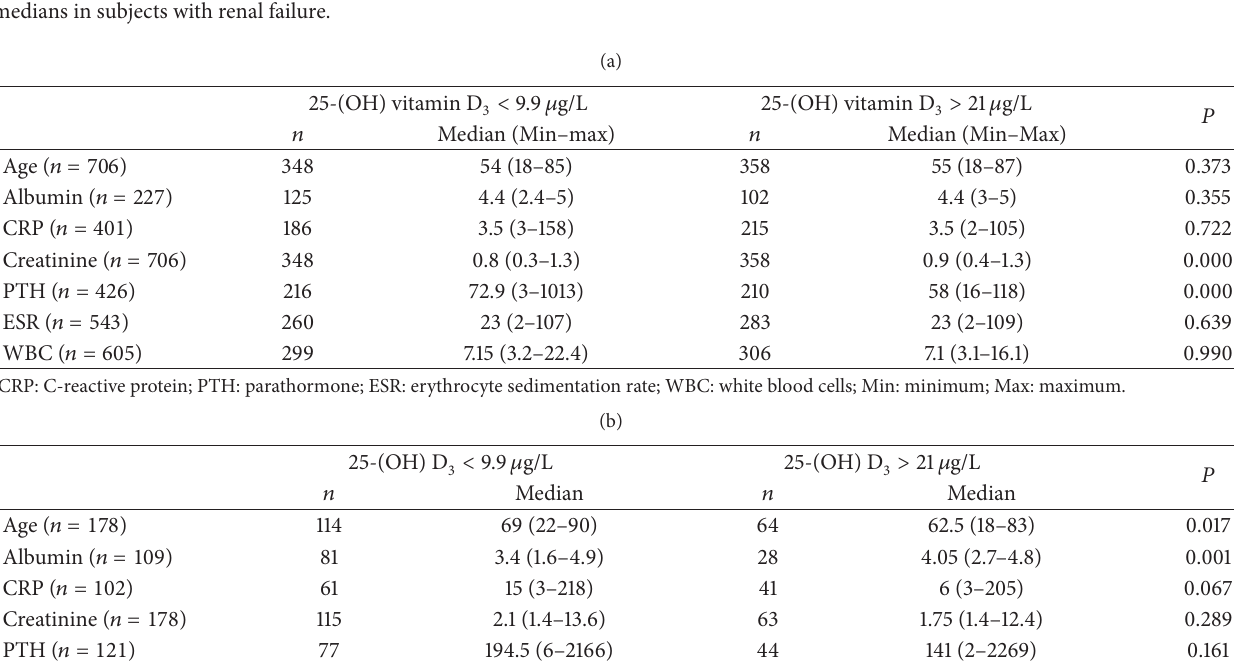
deficient and normal group 3